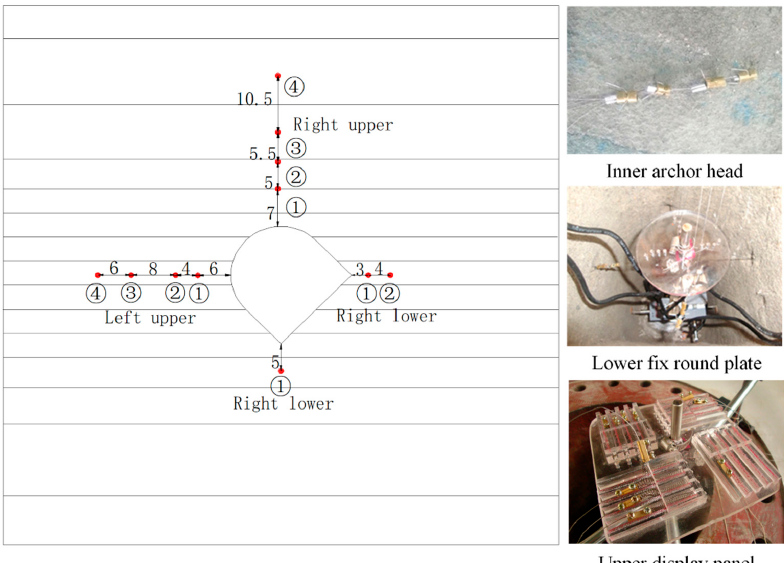
Figure 3. Multipoint displacement meter and its installation